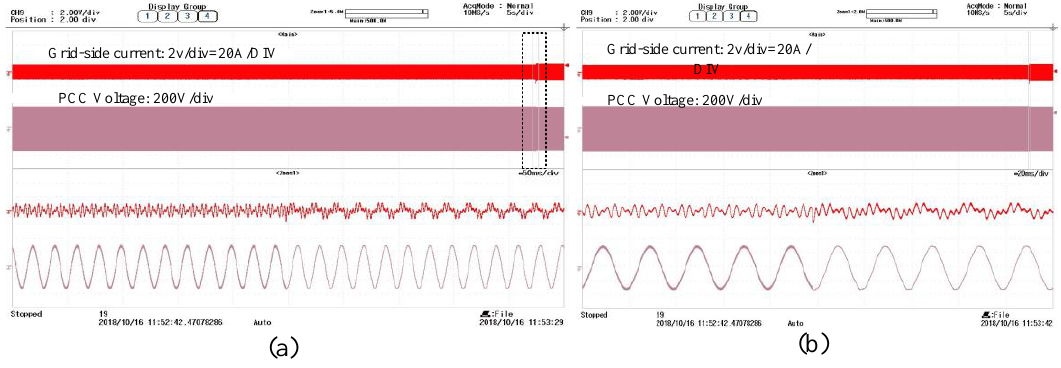
Figure 15. Experimental waveform when the grid impedance changes (C = 600 μF, R = 0.6 Ω). ( a ) The waveform when the system becomes stable; ( b ) zoom of dotted box in ( a ).